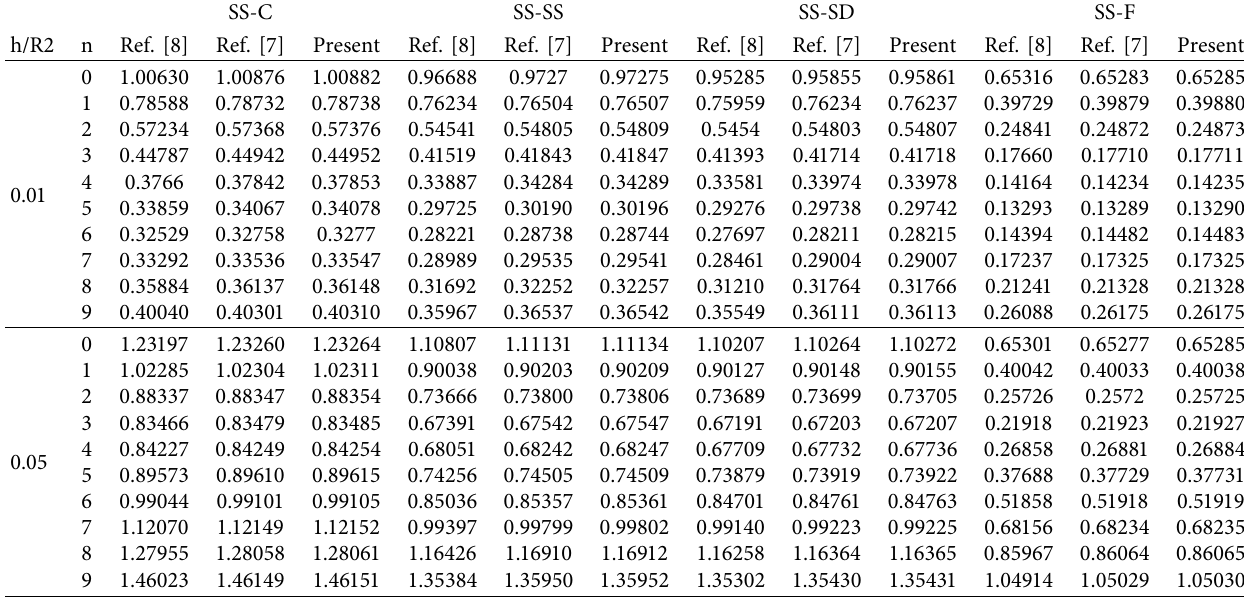
Table 3: Comparison of the frequency parameters Ω � ω R2( ρ h/A11)1/2 for the antisymmetric cross-ply [0 ° /90 ° ]10 conical shell